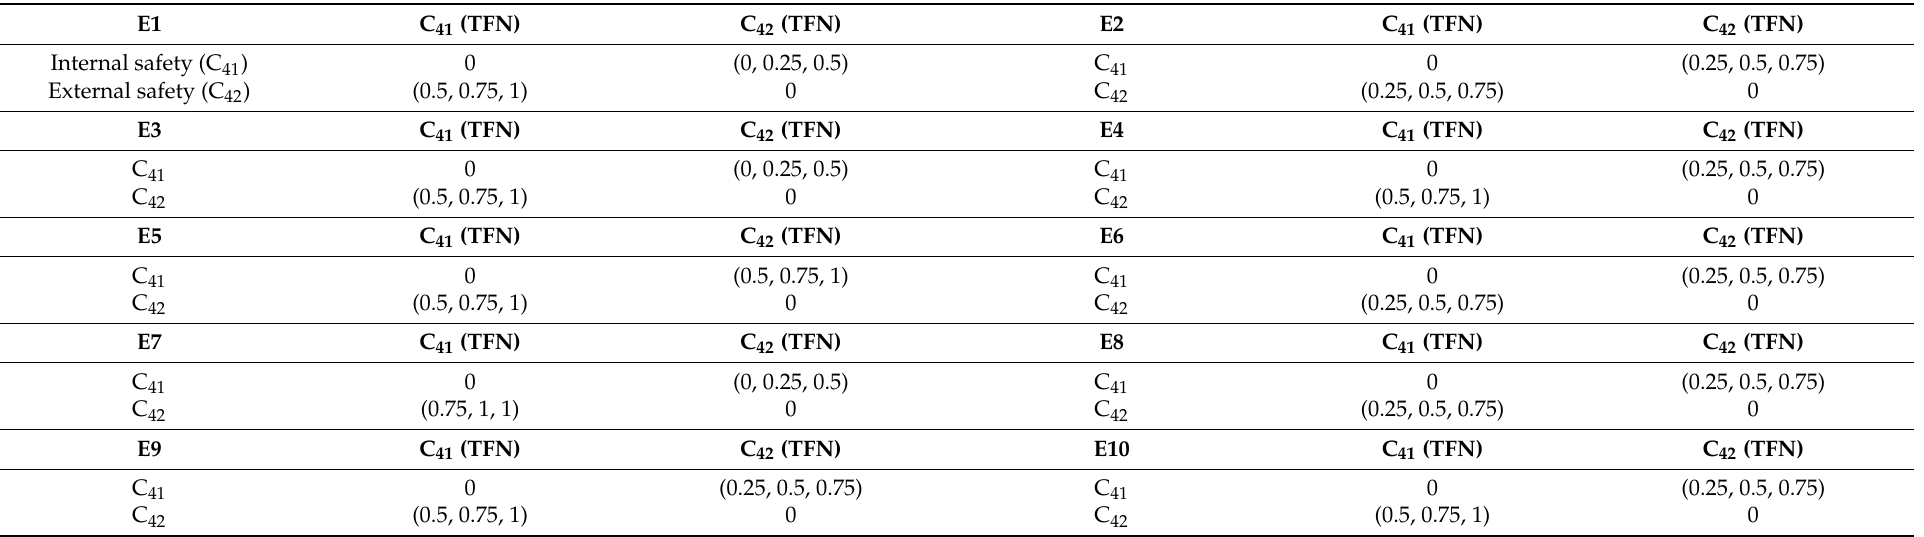
Table A10. The corresponding triangle fuzzy numbers in Table A5.